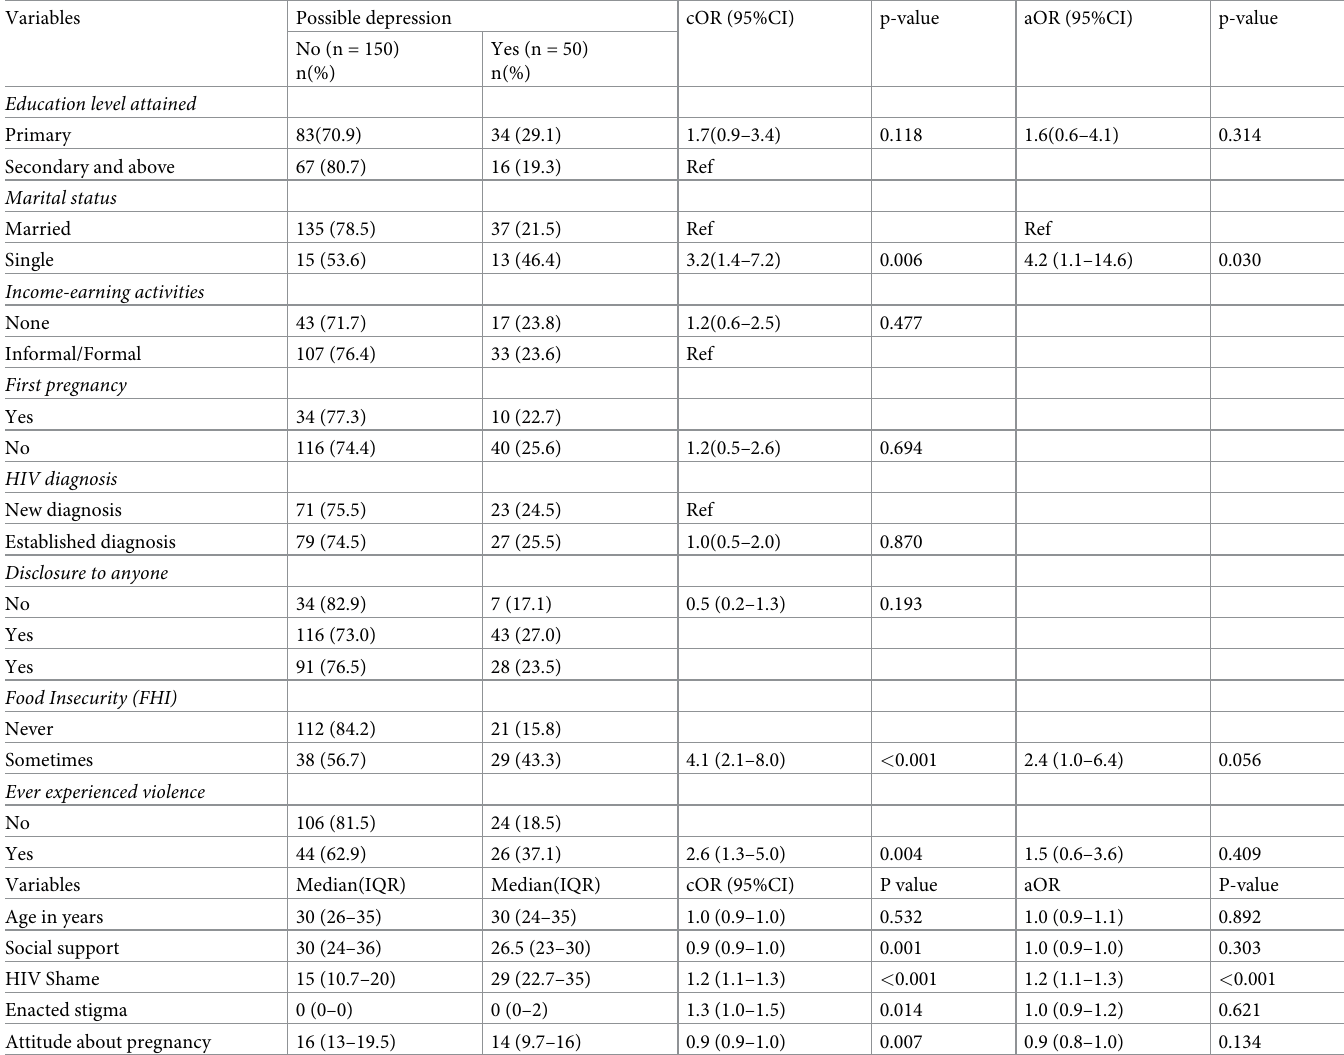
Table 2. Factors associated with depression among pregnant women living with HIV (n =